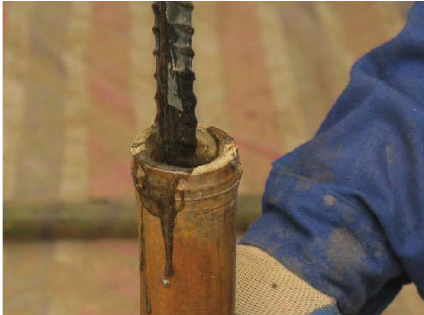
Figure 5: Vernier caliper and loading device.